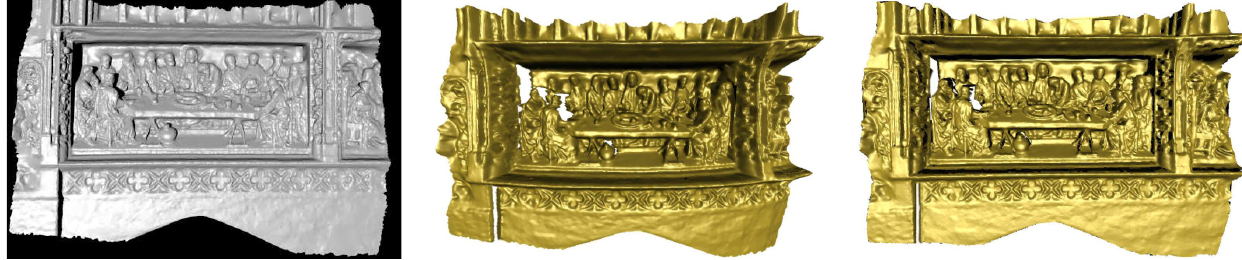
Fig. 2 Comparison of surface reconstruction techniques. Left: input image. Middle: our 3D reconstruction using orthographic projection. Right: our 3D reconstruction using perspective projection. The perspective approach generates a result more compatible with the original